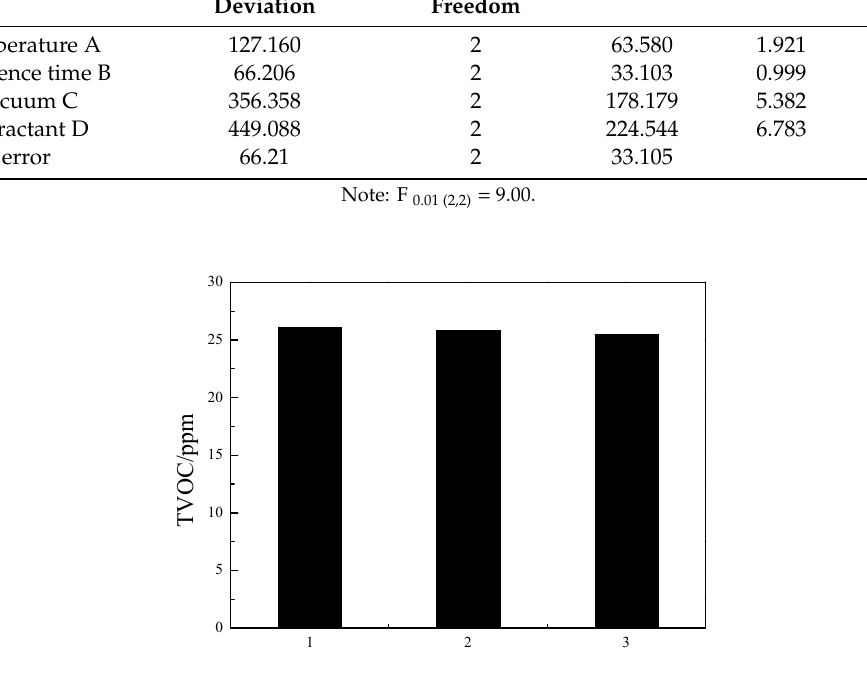
Table 5. Analysis of variance of orthogonal test results.